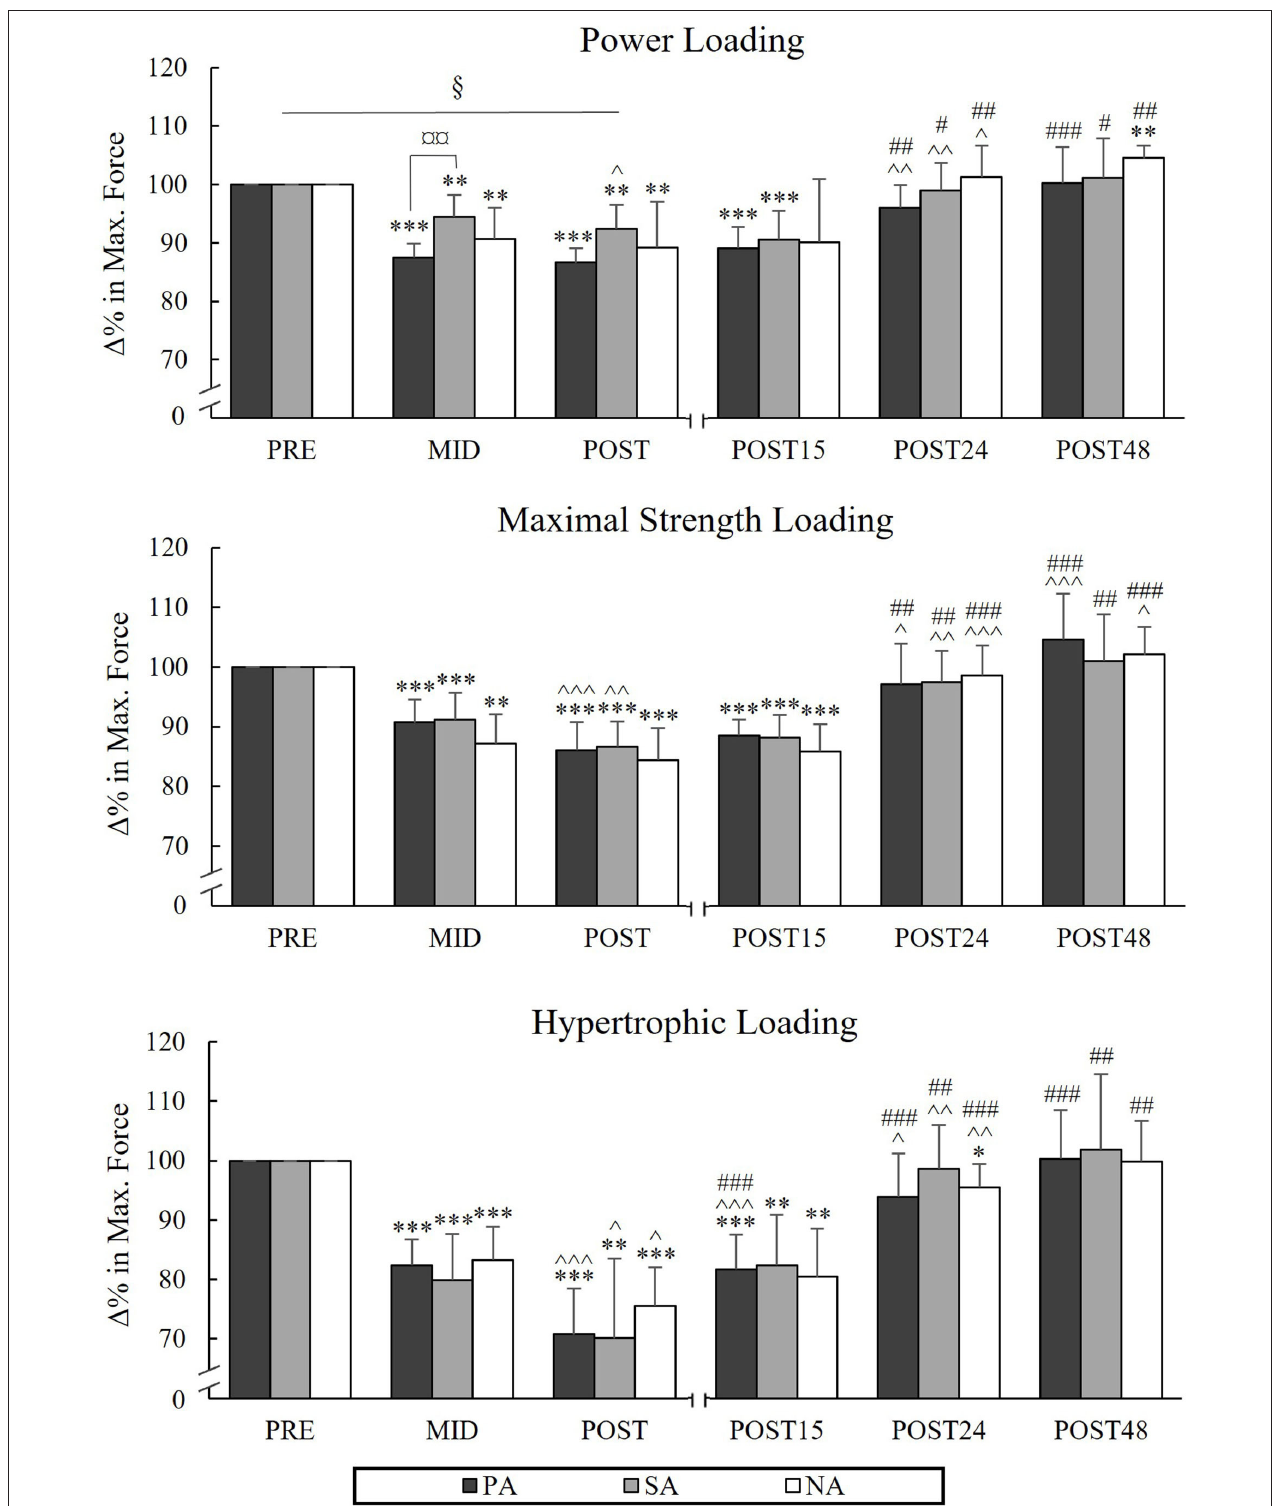
FIGURE 2 | Relative changes in maximal bilateral isometric force during three resistance exercise loadings in power (PA), strength (SA), and non-athletes (NA). * p < 0.05, ** p < 0.01, *** p < 0.001 refer to within-group significances compared to Pre. ∧ p < 0.05, ∧∧ p < 0.01, ∧∧∧ p < 0.001 refer to within-group significances compared to the previous time point. # p < 0.05, ## p < 0.01, ### p < 0.001 refer to within-group significances compared to Post during recovery. § p < 0.05 refers to significant group × time point interaction from Pre to Post. ¤¤ p < 0.01 refers to a significant group difference between PA and SA.